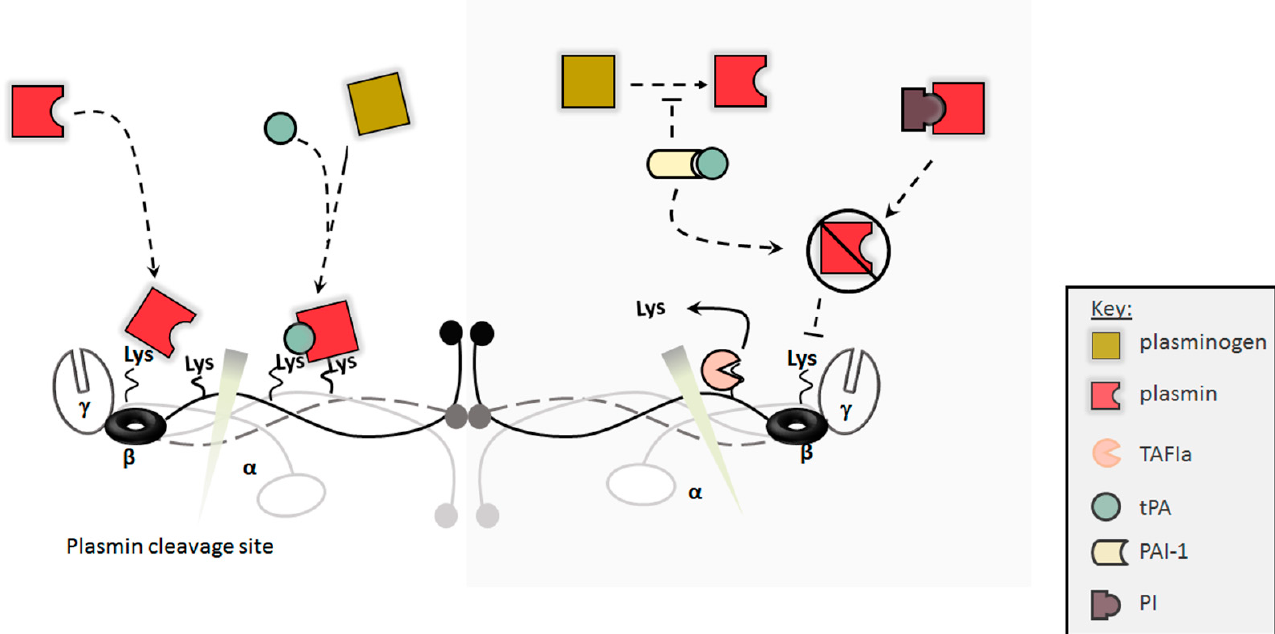
Figure 3. Fibrinolysis. Fibrin clots are broken down by plasmin, which is produced from plasminogen by the tissue plasminogen activator (tPA). Conversion of fibrinogen to fibrin results in the exposure of tPA and plasminogen binding sites. These sites propagate fibrinolysis by enabling the binding of plasminogen and tPA to fibrin network in close proximity, thus enhancing conversion of plasminogen to plasmin. Fibrinolysis is regulated by antifibrinolytic proteins including thrombin activatable fibrinolysis inhibitor (TAFI), plasmin inhibitor (PI) and plasminogen activator inhibitor (PAI-1). Activated TAFI (TAFIa) inhibits the lys-dependent interaction of plasminogen and tPA with fibrin, thus blocking fibrinolysis. PI interacts with Plasmin preventing plasmin-mediated cleavage of fibrin. PAI-1 interacts with tPA inhibiting the conversion of plasminogen to plasmin.